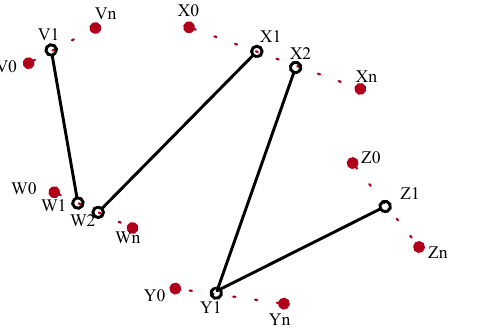
Figure 3. A time-dependent moving target rendezvous sequence with time